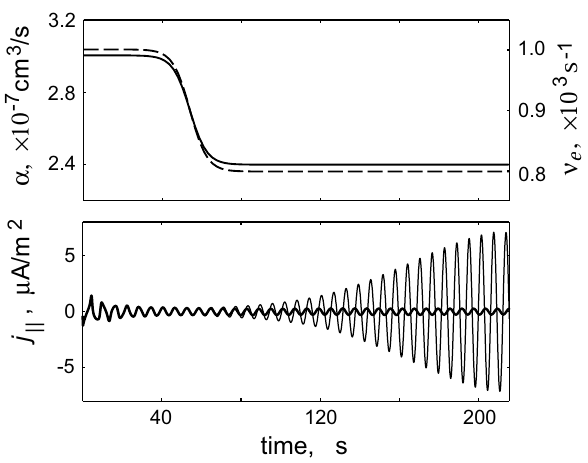
Fig. 2. (Top) Time variations of the ionospheric plasma recombina- tion coefficient, α , (solid line) and the electron collision frequency, ν e , (dashed line). (Bottom) Time variations of the field-aligned cur- rent density, j k measured at the ionosphere at L =6.2 when the heater is turned off all the time (thick line) and when the heater is turned on after t =40s (thin